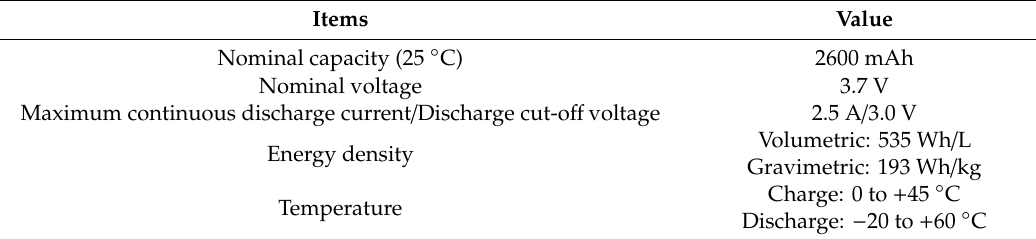
Table 1. Specifications of UR18650ZY key parameters.